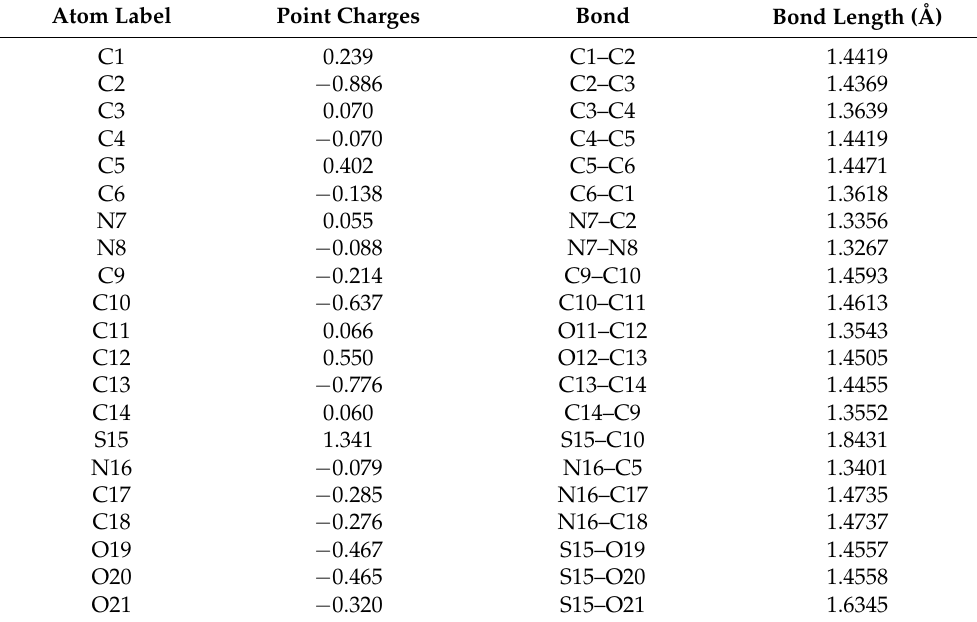
Table 2. Point charges and bond length on atoms of MO at the B3LYP/6-31+G(d,p) level. Atom